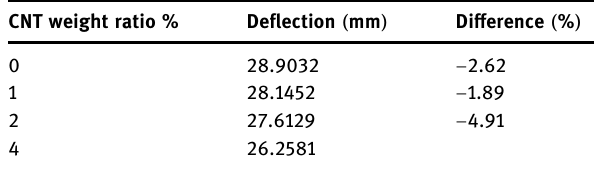
Table 13: Maximum de fl ection of the beam with di ff erent CNT weight ratio rebars under static loading